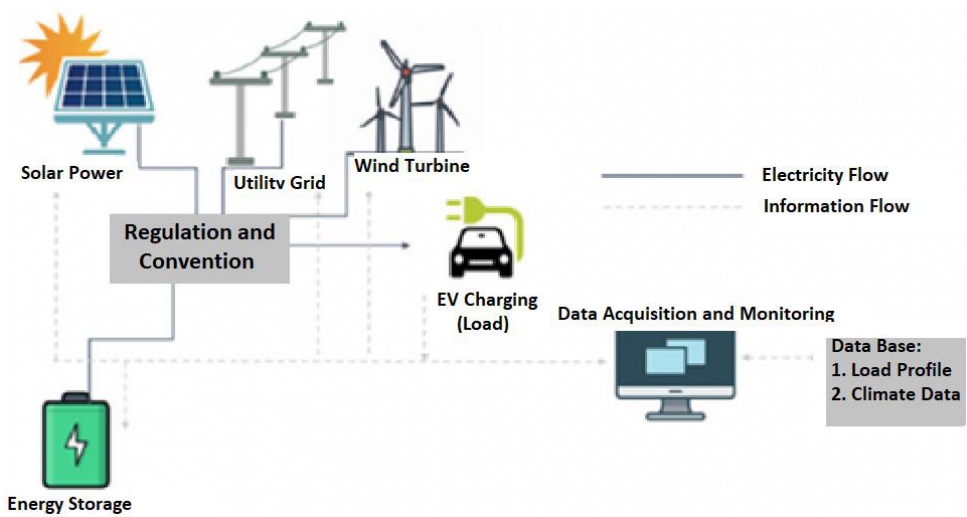
Figure 5. Schematic of the proposed system .